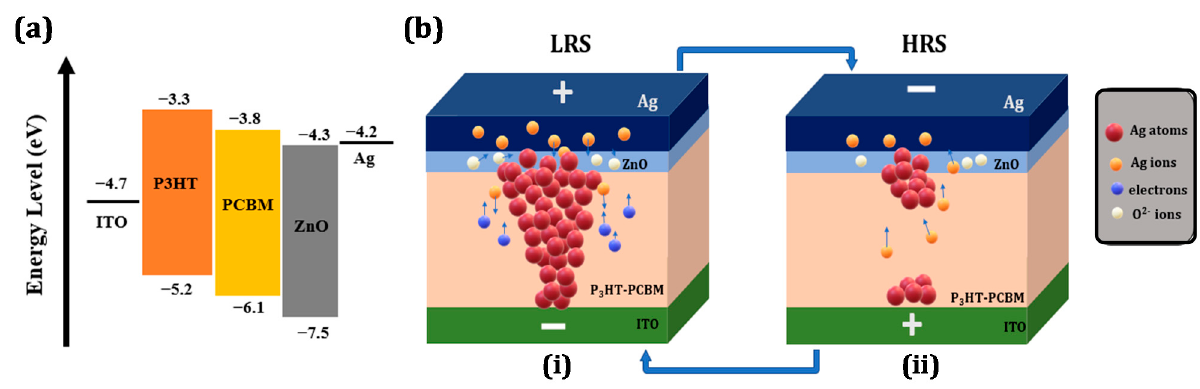
Figure 4. ( a ) Energy band diagram of proposed device structure. ( b ) Schematic presentation of resistive switching mechanism in HRS and LRS, respectively.